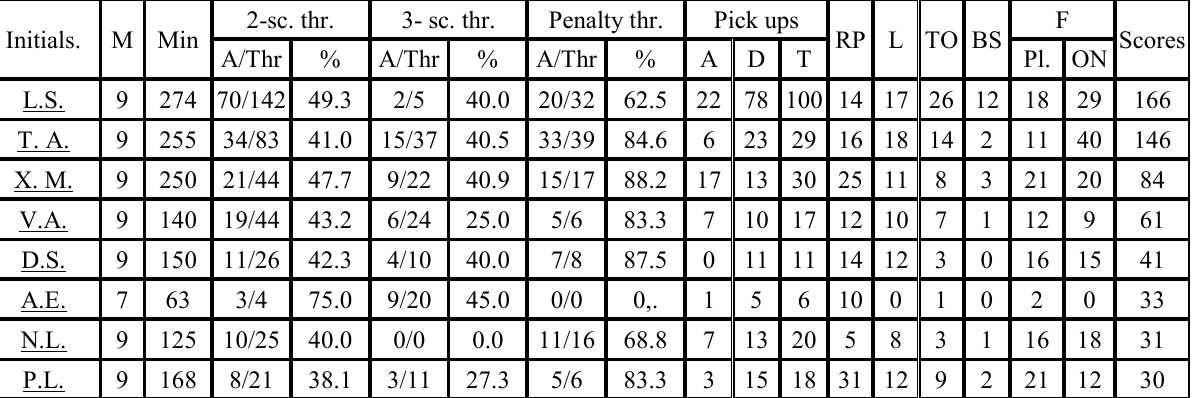
Indicators of technical-tactic actions of female basketball players of combined team of Spain at final tournaments of European championship